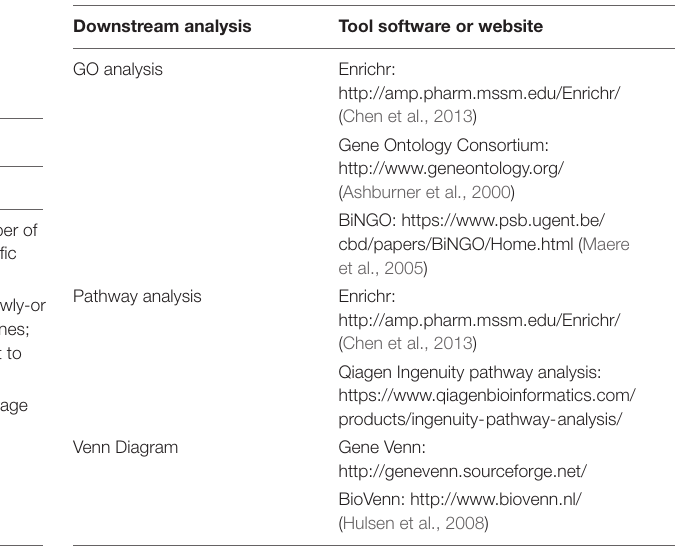
TABLE 2 | Basic bioinformatic tools for gene profiling